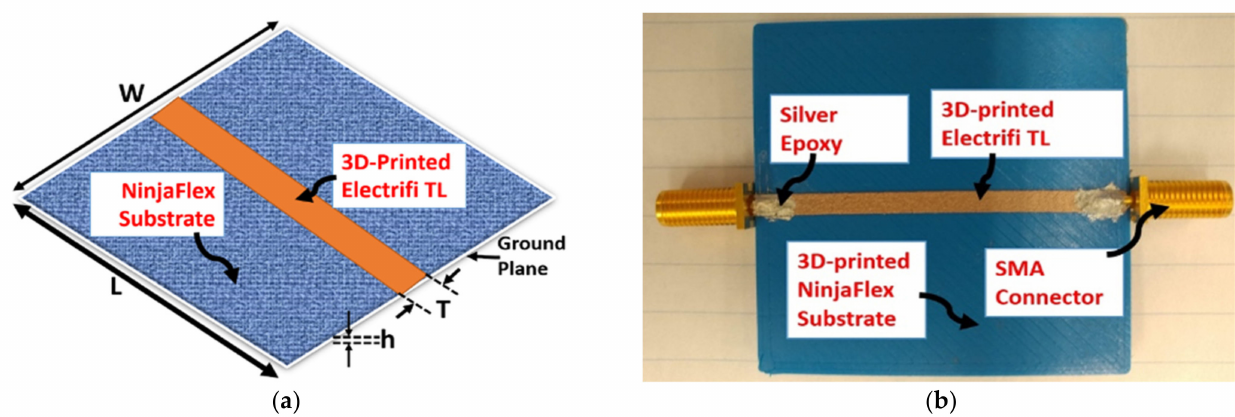
Figure 2. ( a ) The geometry of 50 Ω TL made of Electrifi and NinjaFlex filaments (W = L = 50, T = 2.8, and h = 1.2, all in mm, thickness of the Electrifi trace was 0.2 mm); ( b ) prototype of the Electrifi TL on 3D-printed flexible NinjaFlex substrate (top view). Commercial adhesive copper (1 mil thick) foil was used as the ground plane (not shown here).